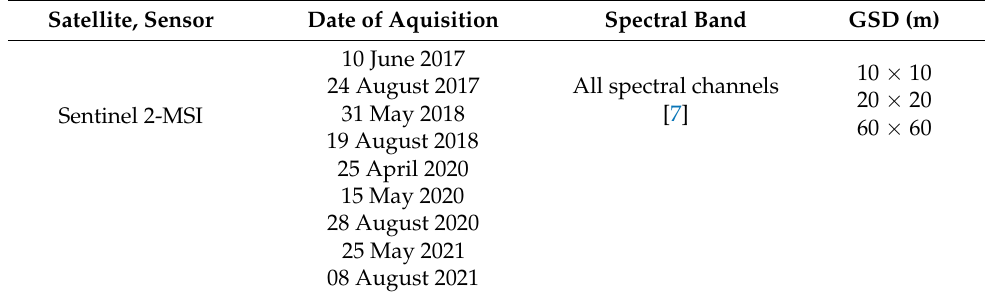
Table 1. Satellite imagery